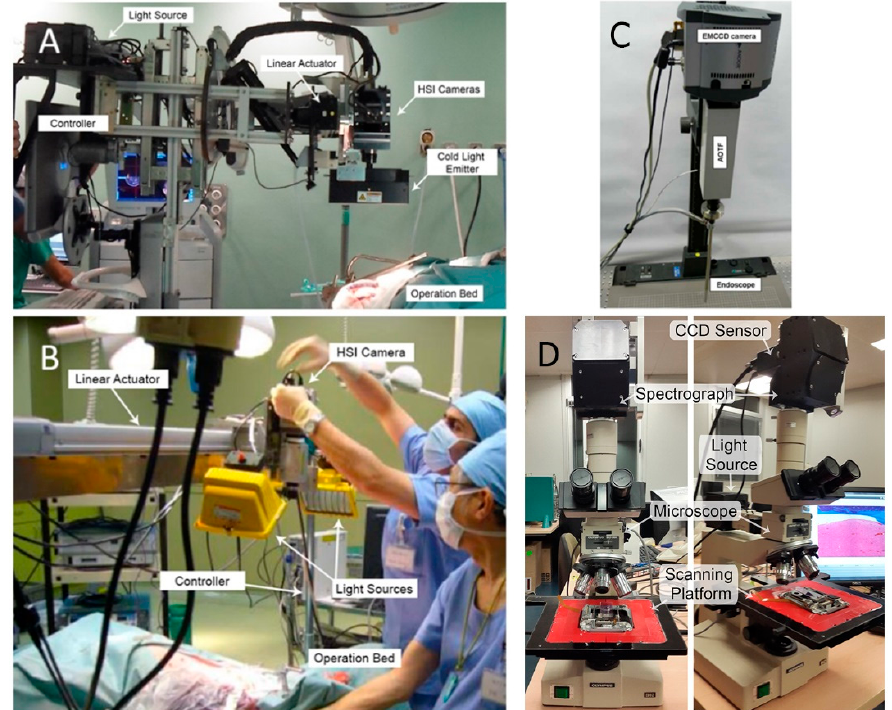
Figure 3. HS acquisition system used in medical applications. ( A , B ) HSI acquisition systems based on push-broom cameras for in-vivo human brain tumor detection [40] and in-vivo pig abdominal surgery [20]; ( C ) Liquid crystal tunable filter camera attached to an endoscope for cancerous tissue detection [43]; ( D ) Microscope coupled to an HSI push-broom camera for pathological slides registration [36].